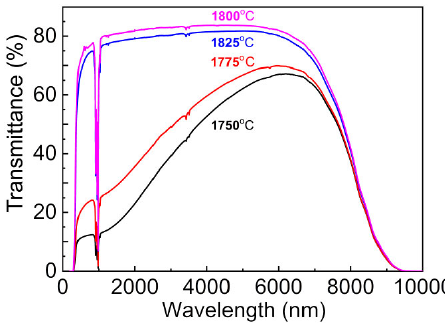
Fig. 12 Optical transmittance spectra of 1.5 mm thick (Y 0.93 Yb 0.05 La 0.005 Zr 0.015 ) 2 O 3 ceramics sintered at different